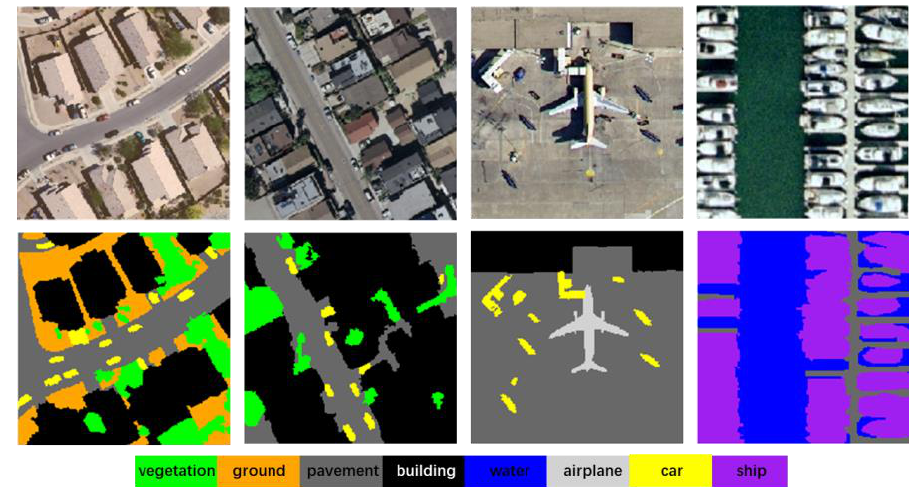
Table 1. The class distribution for the UCM dataset (%).